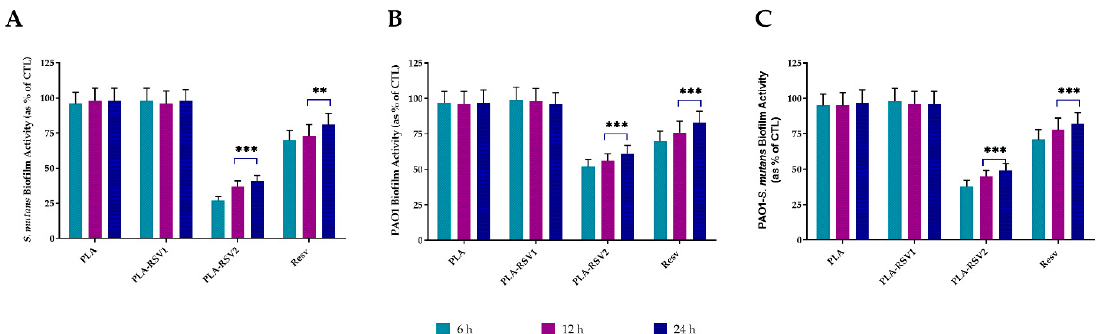
Figure 9. Biofilm metabolic activity of RSV-loading membranes. Biofilm metabolic reduction was quantified using BacTiterGlo™ assay and correlating the recorded luminescence with APT nmoles, after 6, 12, and 24 h of incubation at 37 °C in presence of ( A ) Streptococcus mutans , ( B ) PAO1, and ( C ) PAO1- S. mutans as described in the material and methods section. Biofilm activity was reported as a percentage in comparison with positive bacterial controls. A total of 200 µ M resveratrol was used as positive standard control (RSV). For each sample, six different experiments were conducted, and the results expressed as the mean of the values obtained (mean ± SD). Statistically significant variations: ** p < 0.01 and *** p < 0.001 versus PLA and PLA-RSV1.